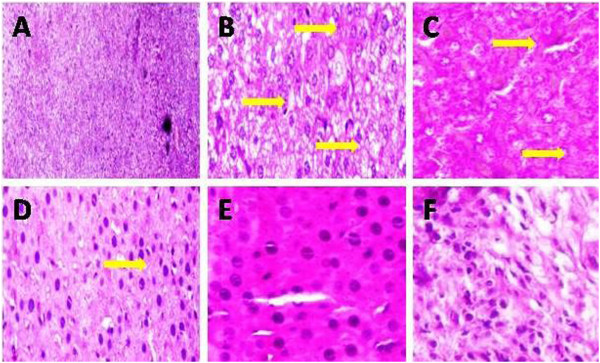
Paederia Foetida Linn. leaves extract effect on liver histopathology in normal and STZ induced diabetic rats. (A) Normal control: Normal control group did not display any changes (B) Diabetic control: Display the fat deposition (Yellow arrow) (C)PF I (100 mg/kg): Histopathology display the some pat having the micro droplet of fat deposition (Yellow arrow) (D)PF II (250 mg/kg): PF treated drug displaying the fat deposition (Yellow arrow) (E)PF III (500 mg/kg): PF treated group did not display the any changes and fat deposition of the liver histopathology (F) Glibenclamide (10 mg/kg): Glibenclamide treated group did not display any changes, histopathology similar to the normal control group. The samples were obtained from the same liver anatomical regions. For each group, 6 rats were examined and 50 pictures were taken. Original magnification, 40×.